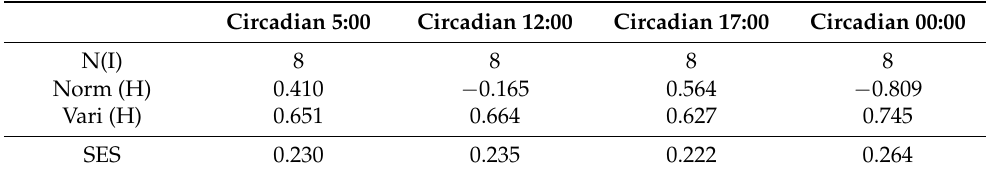
Table 5. Normalized entropy production from normal and abnormal (heat-based) day–night temperature effects.